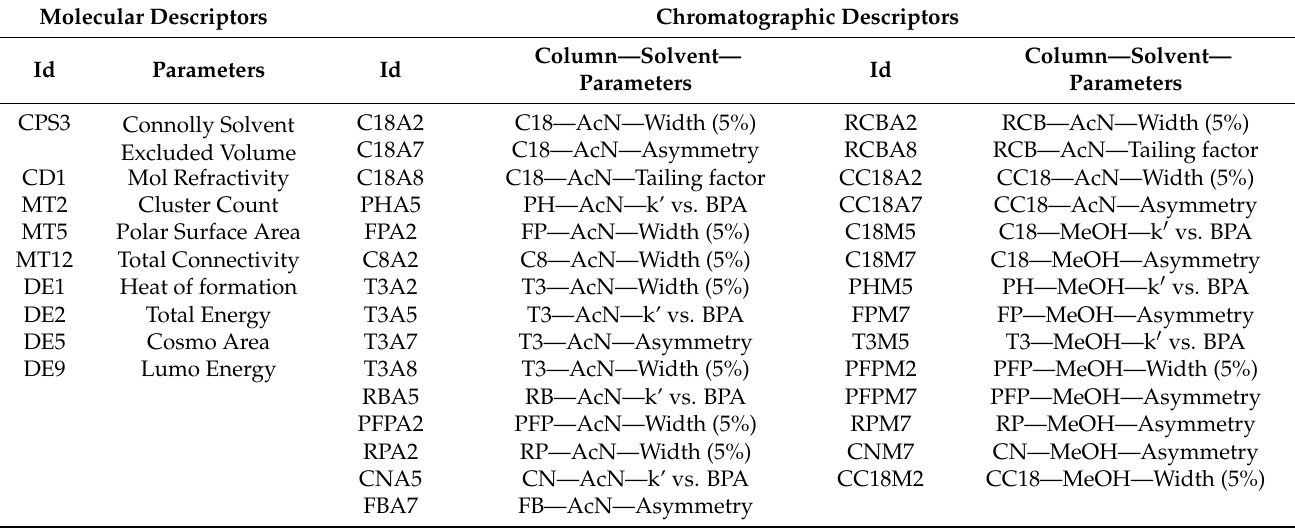
Table 3. Molecular and chromatographic descriptors selected to build QSAR for predicting placental CI, i.e., with weight in the artificial neural networks higher than twice the median of all descriptors’